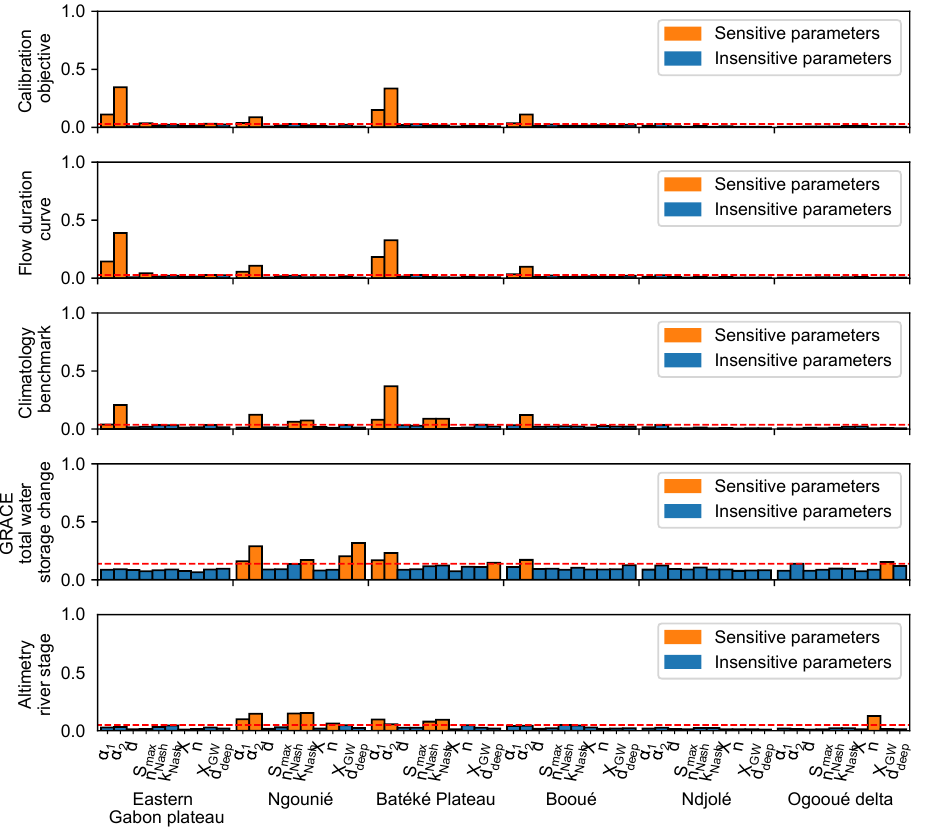
Figure 6. Sensitivity analysis of the model parameters on contributions to aggregated objective function (top) on (from second row down) FDC, climatology, GRACE and altimetry water height. The 10 most sensitive parameters are highlighted for each